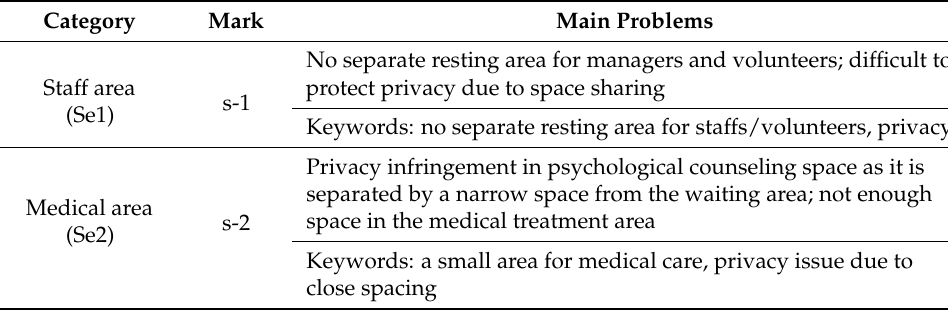
Table 7. Problems identified in the service